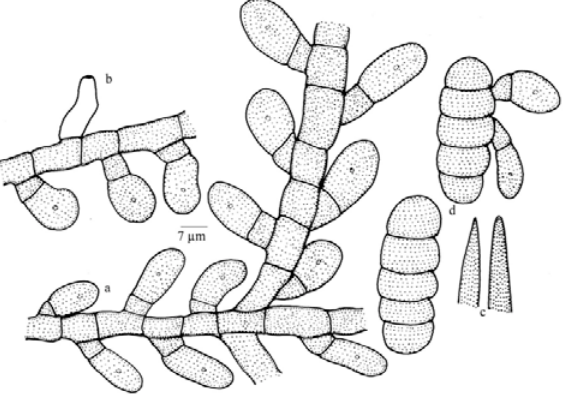
Figure 44. Meliola ardisiicola a - Appressorium; b - Phialide; c - Apical portion of mycelial setae; d -